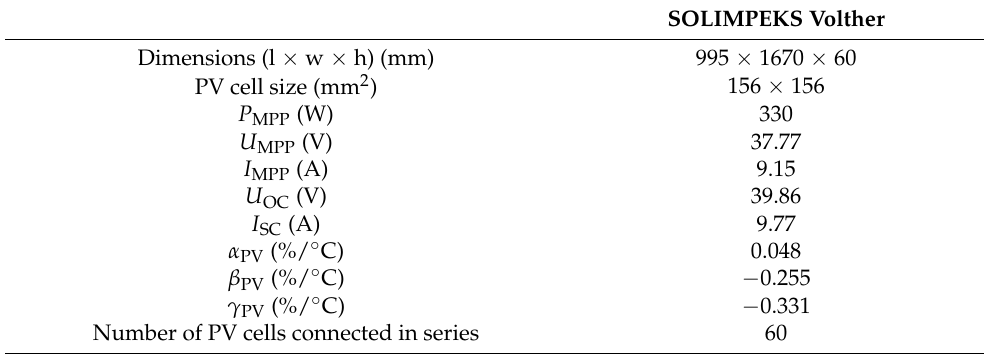
Table 1. Parameters of the considered mono-crystalline PV/T collector under STC